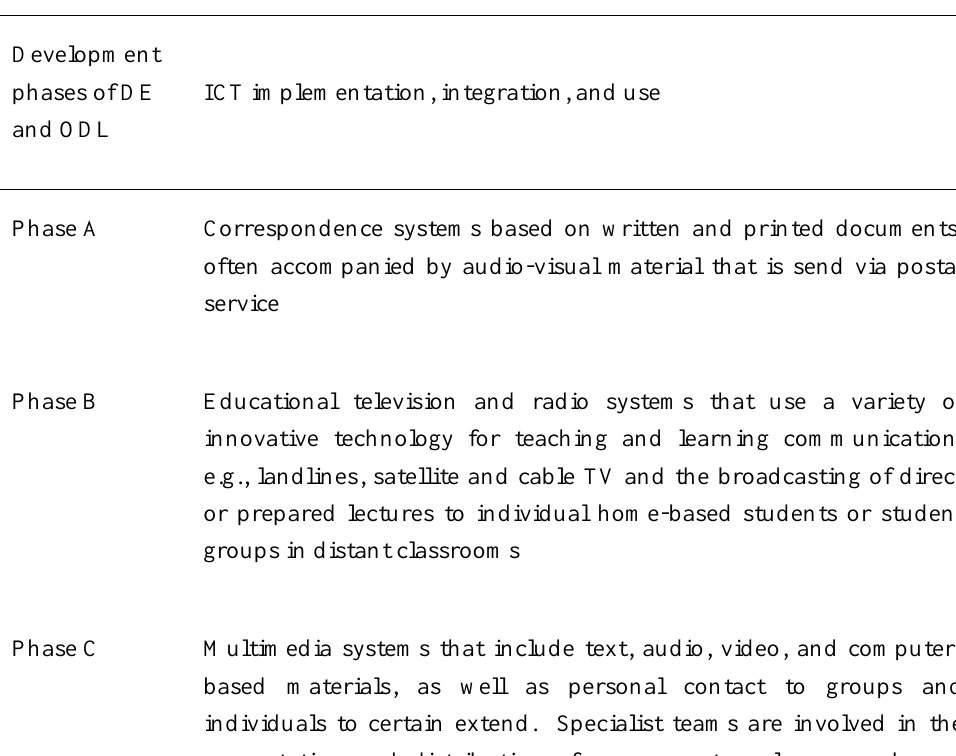
UNESCO Development Phases of DE and ODL according to ICT Implementation, Integration, and